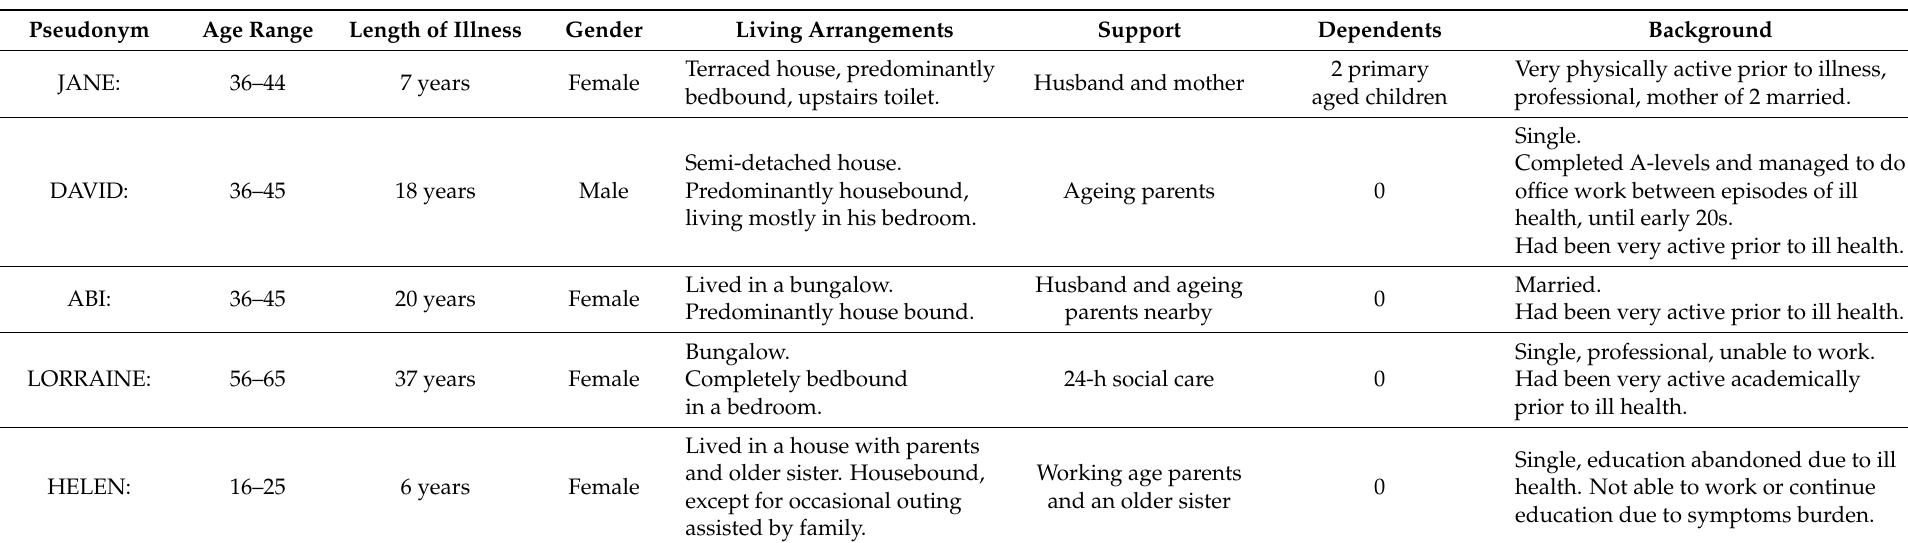
Table 1. Participant